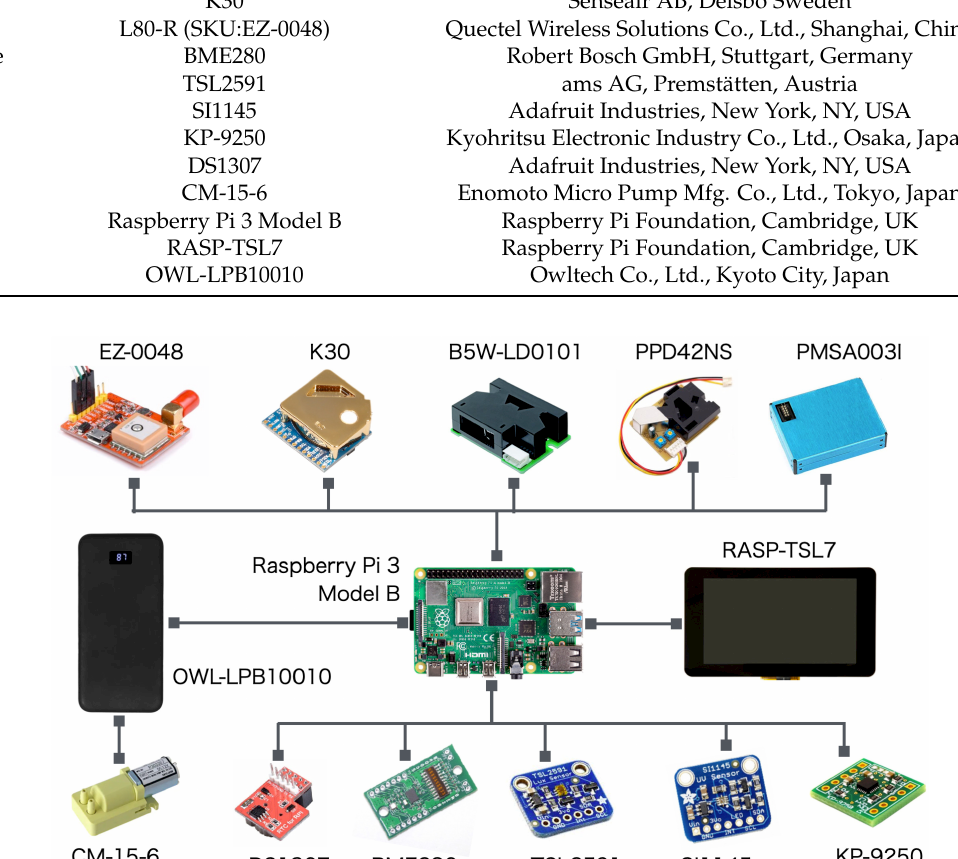
Figure 2. Connection details of respective parts for assembly.